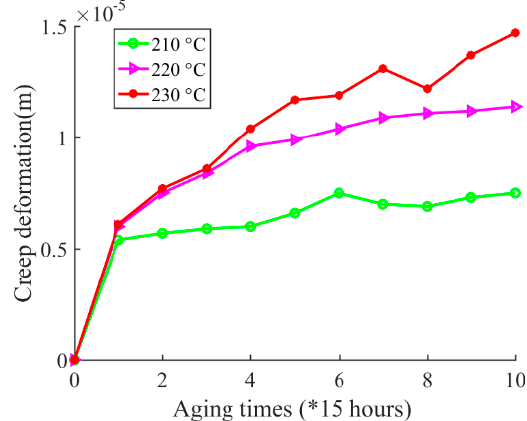
Figure 13. Inter-turn insulation creep deformations under 210 °C, 220 °C, and 230 °C.